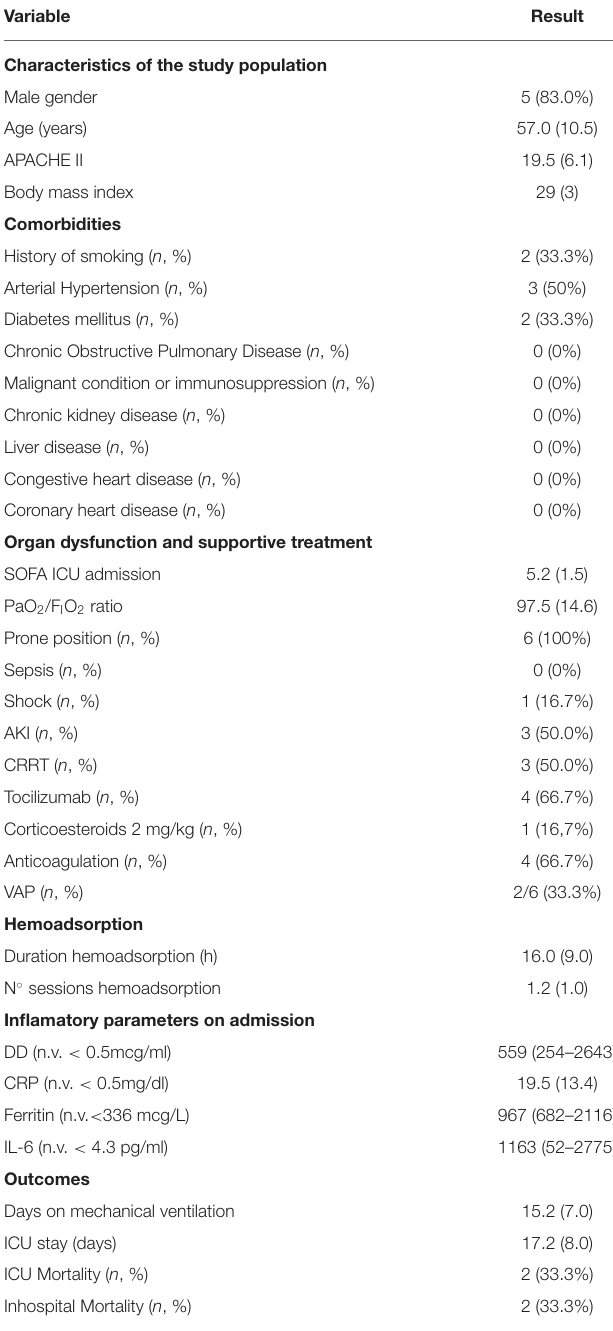
TABLE 1 | Clinical patient